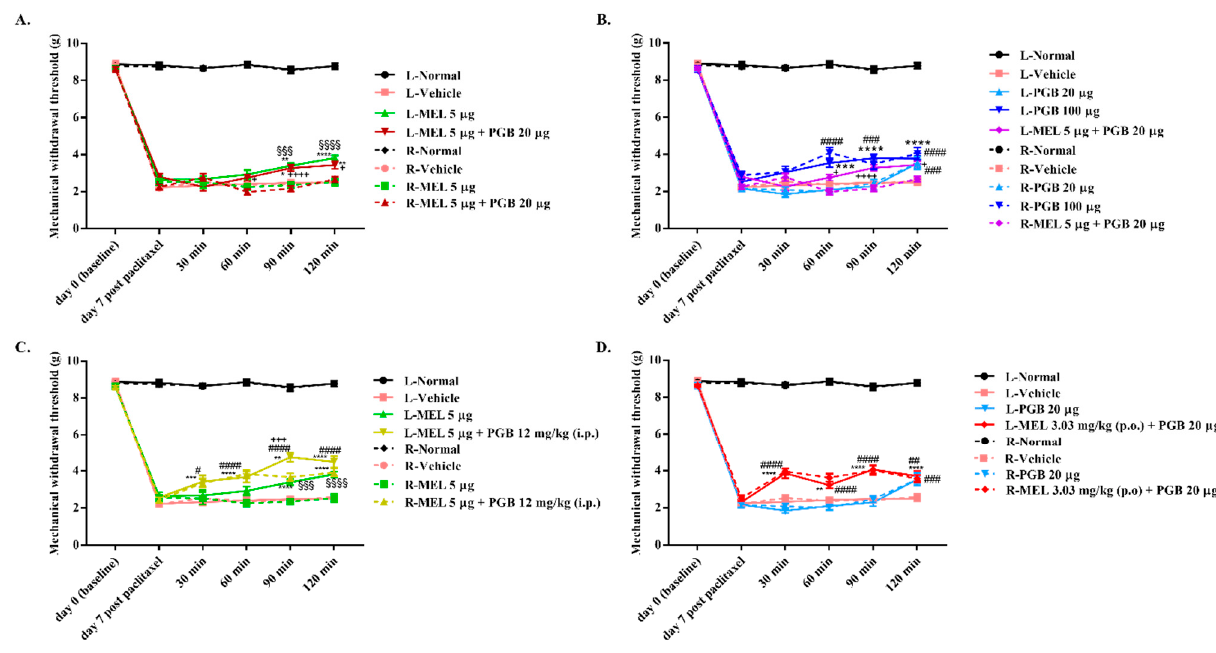
Figure 3. Antinociceptive effect of intraplantar or systemic administration of MEL, PGB, and MEL- PGB on paclitaxel-induced neuropathic pain in mice. Time course effects on the MWTs produced by intraplantar administration of MEL, PGB, and MEL-PGB in mice ( A , B ). The analgesic effect of combined administration of MEL and PGB was more significant than monotherapy with intraplantar administration of MEL or PGB ( C , D ). L and R represent the left and right hind paws of the mice, respectively. * p < 0.05, ** p < 0.01, *** p < 0.001, and **** p < 0.0001 versus L-vehicle by two-way